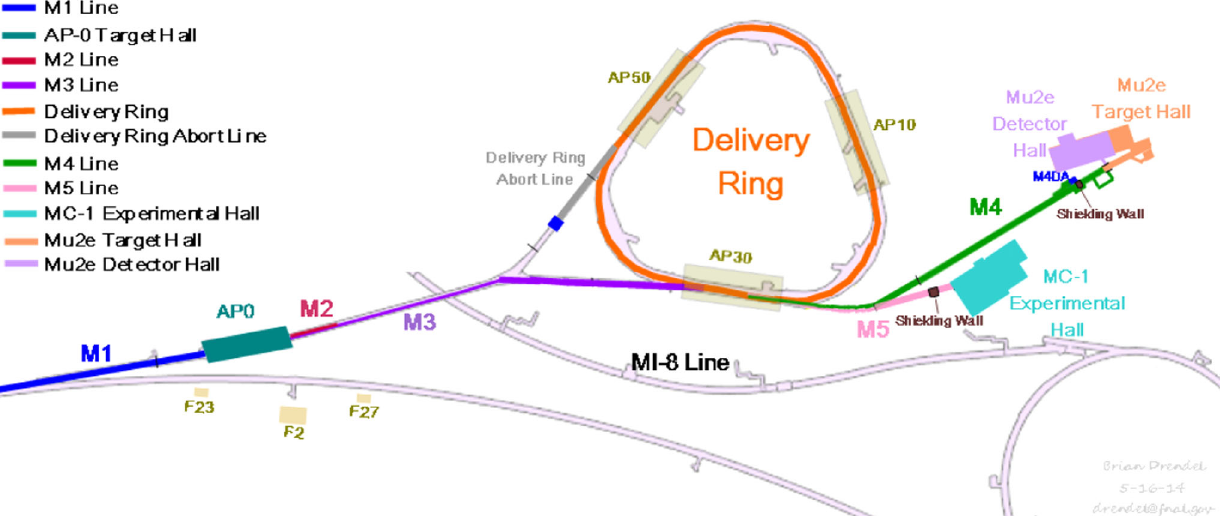
FIG. 1. A schematic representation of the Muon Campus accelerator complex that is used by the Muon g − 2 experiment. Secondaries are produced on a target that then travel through the M2 and M3 lines, which are designed to capture as many 3 . 1 GeV =c muons from pion decays as possible. The beam is injected into the DR, wherein a kicker is used to remove the protons, the resulting muon beam is then extracted into the M4 line, and the muon beam is eventually transferred to the M5 line that leads to the muon storage ring (enclosed in the MC1 hall). The combined M2 and M3 line and M4 and M5 line lengths are 280 and 130 m, respectively, along with the DR that has a circumference of 505 m.